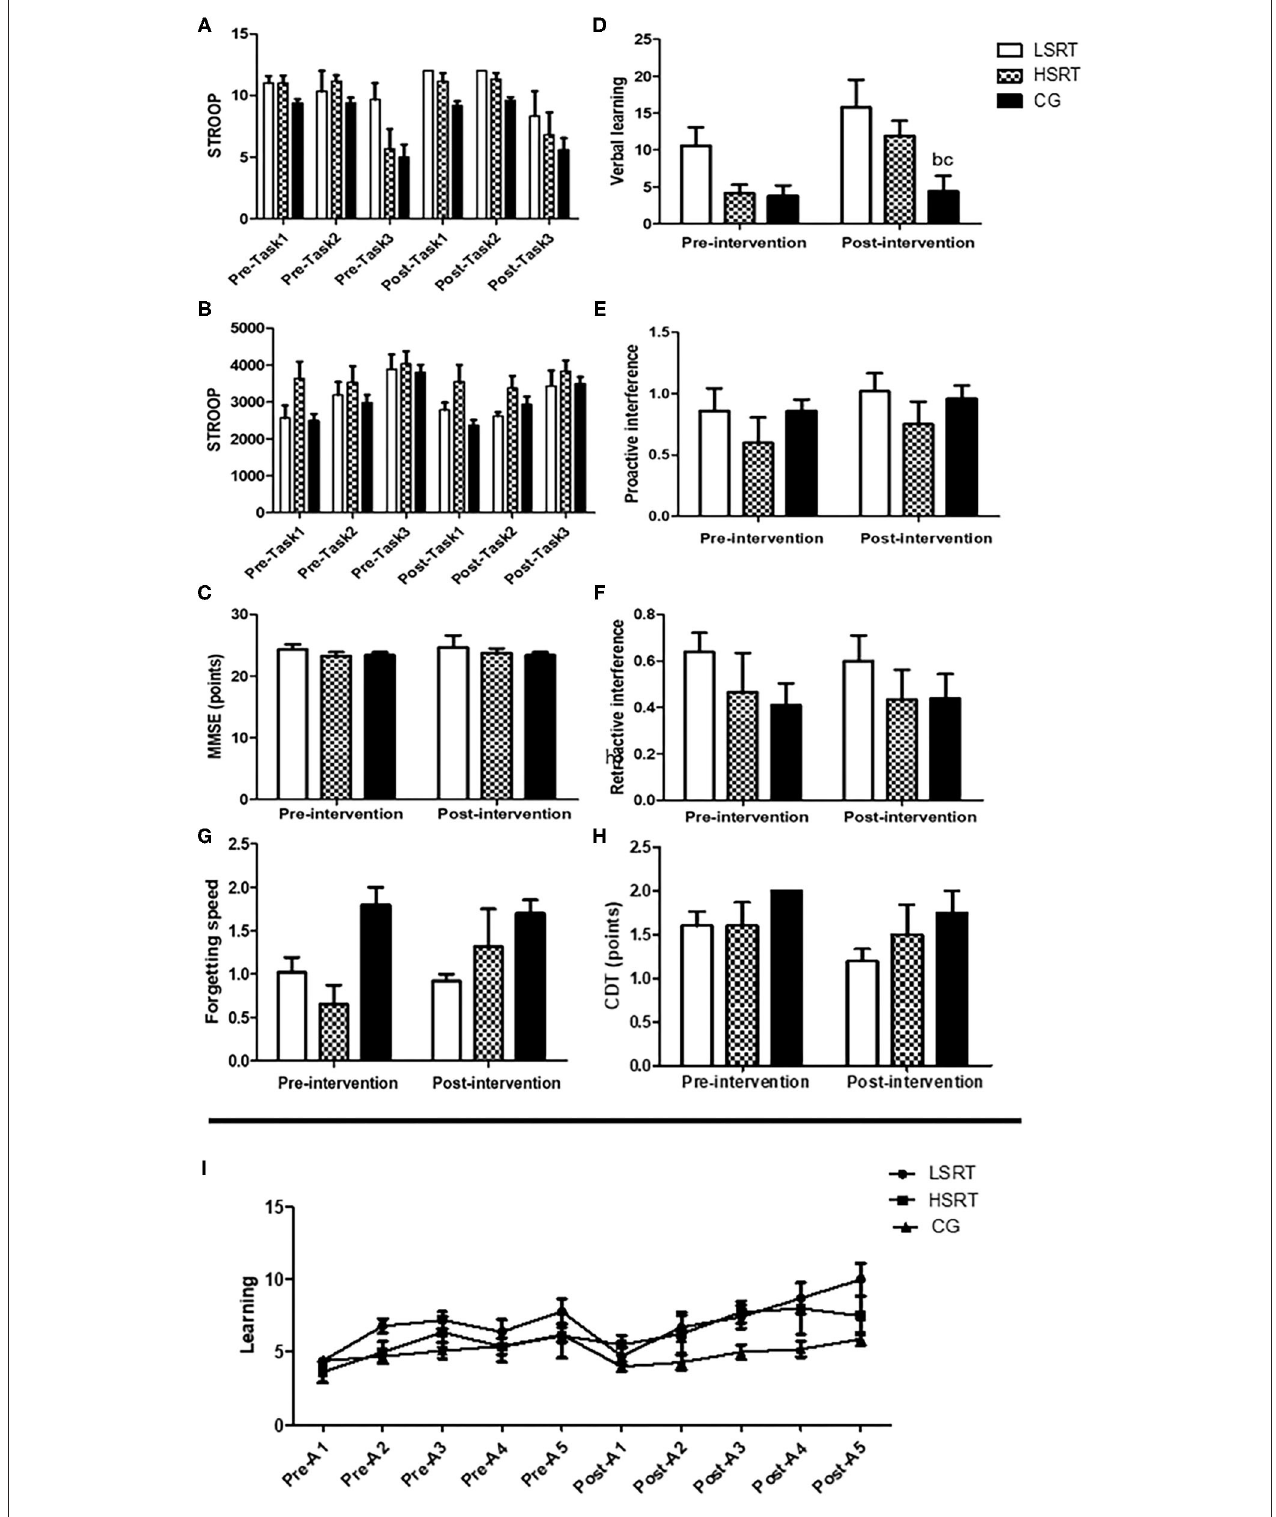
FIGURE 3 | Effects of RT on cognitive parameters in prefrail older adults. Stroop test (A,B) , Mini-mental state examination (MMSE; C ), The Rey’s auditory verbal learning test (D–G,I) and Clock Drawing Tests (H) . LSRT, Low-speed resistance training; HSRT, High-speed resistance training; CG, Control group; MMSE, b P < 0.05 vs. LSRT; c P < 0.05 vs.